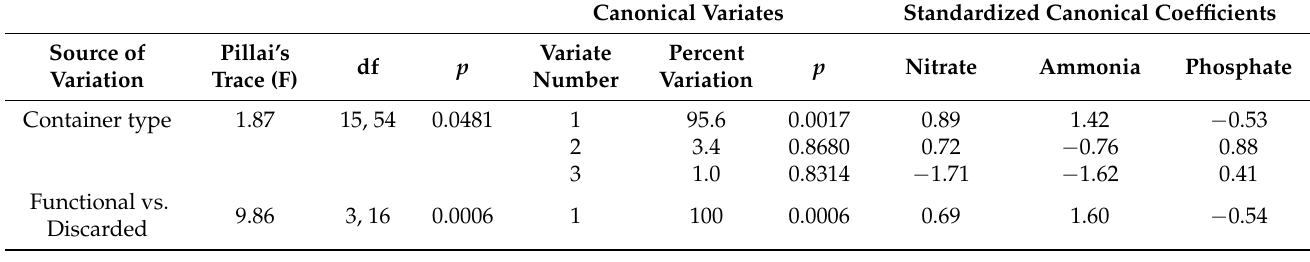
Table 3. MANCOVA results and standardized canonical coefficients for container water quality.